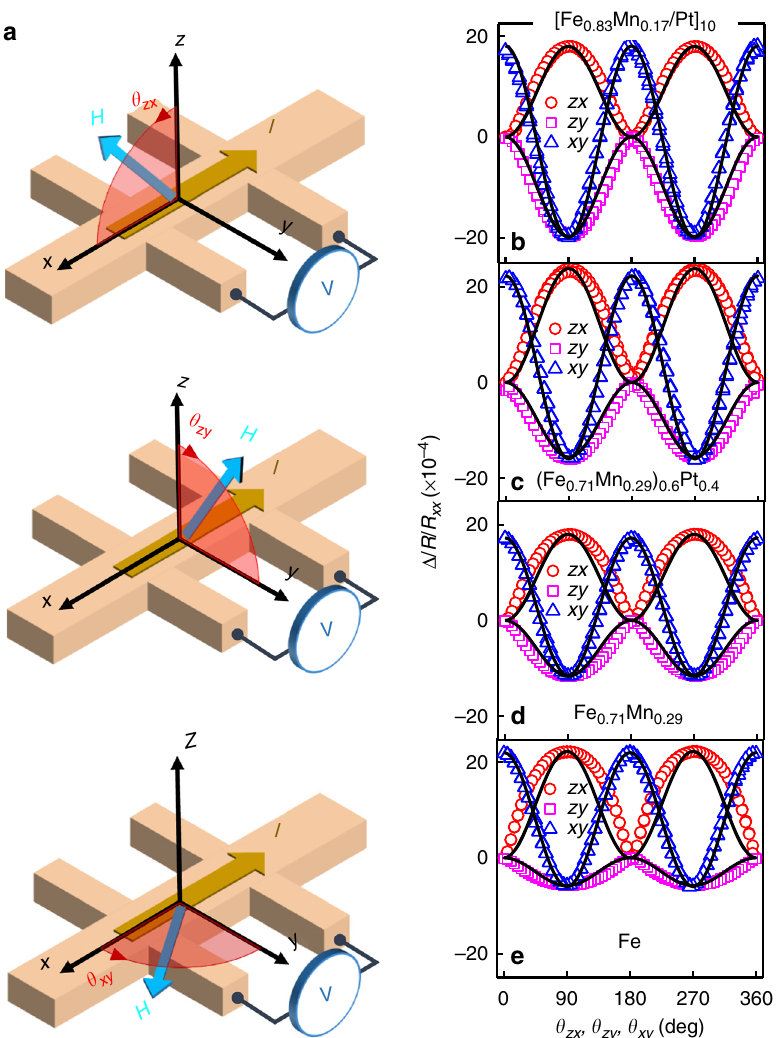
Fig. 2 ADMR measurement geometry and typical results. a Schematic of measurement geometry. b – d ADMR measurement results: b [Fe 0.83 Mn 0.17 (0.6)Pt (0.4)] 10 /Pt(1) multilayer; c co-sputtered (Fe 0.71 Mn 0.29 ) 0.6 Pt 0.4 (9); d Fe 0.71 Mn 0.29 (9); and e Fe. Solid lines in b – e are fi ttings based on the angle